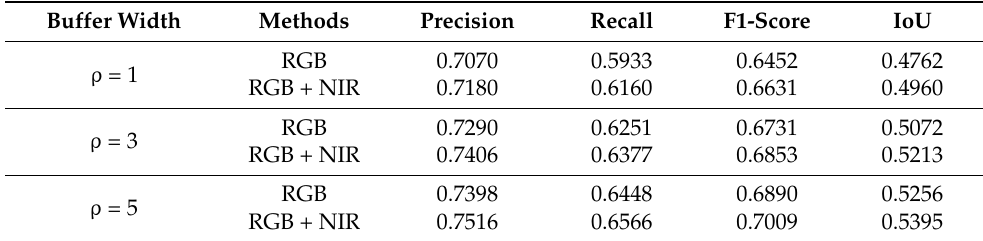
Table 5. Experimental results of road centerline extraction with different band selection under different buffer widths ( ρ